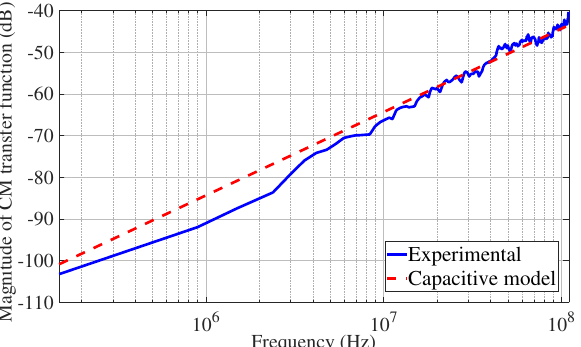
Figure 14. Common-mode transfer function obtained by experimental results (continuous line) and the fitted one (dashed line). The capacitive model is effective in predicting the CM EMI